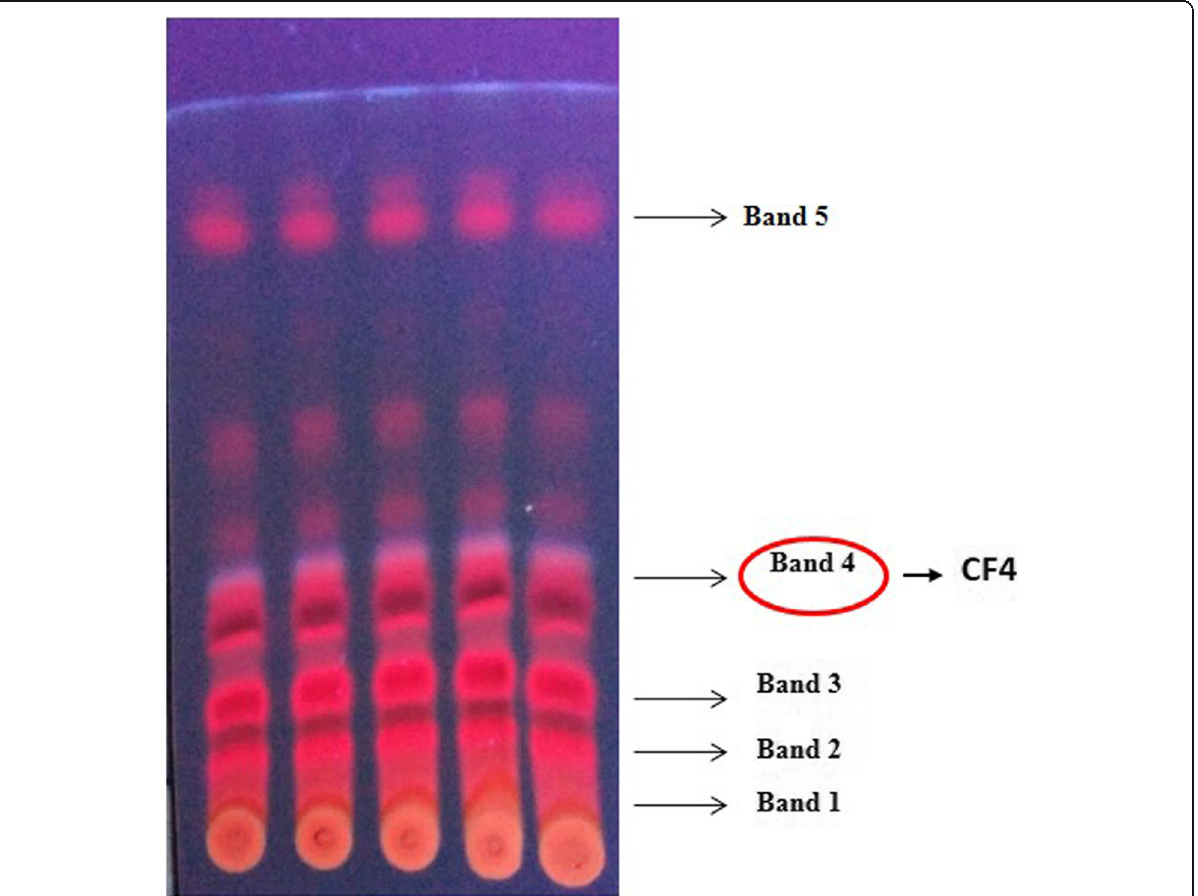
Fig. 1 TLC separated fractions of C. minima as observed under UV